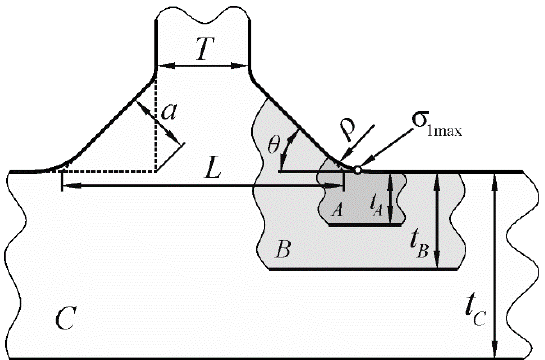
Figure 13. Characteristic dimensional proportions representing the influence of characteristic geo- metrical dimensions on SCF.